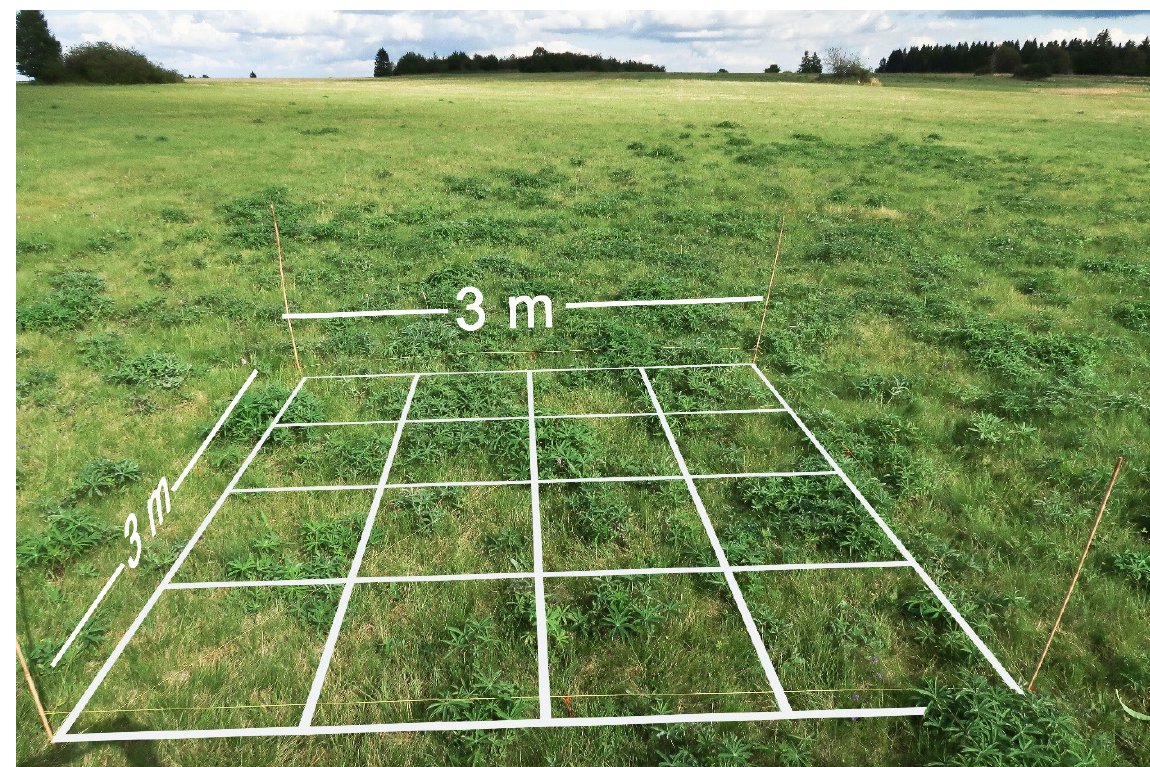
Figure 2. Regrowth of L. polyphyllus after mowing on extensive grasslands at the Rhön UNESCO Biosphere Reserve in early September 2020.